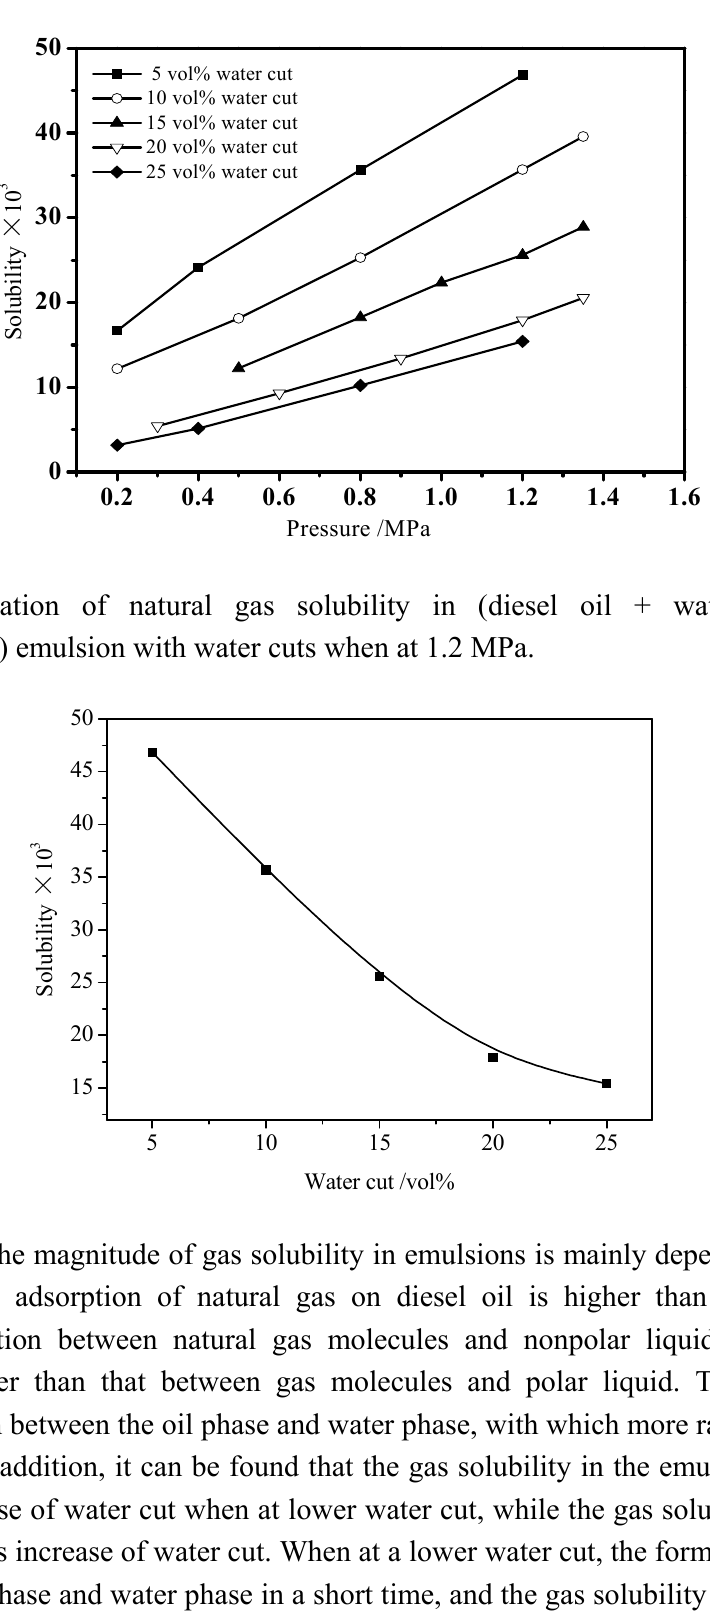
Figure 4. Variation of solubilities of natural gas in (diesel oil + water +3 wt% anti-agglomerant) emulsion systems with pressures and water cuts when at 277.2 K.